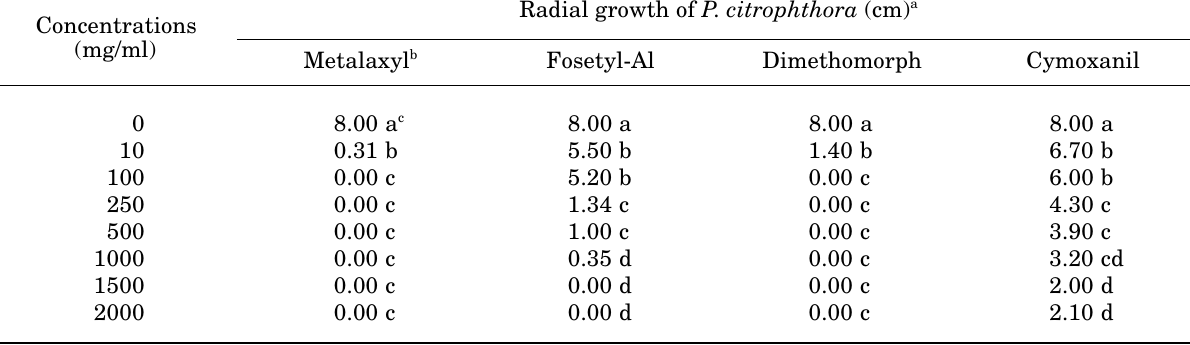
Table 2. Effect of metalaxyl, fosetyl-Al, dimethomorph and cymoxanil at various concentrations on radial growth of Phytophthora citrophthora in vitro.